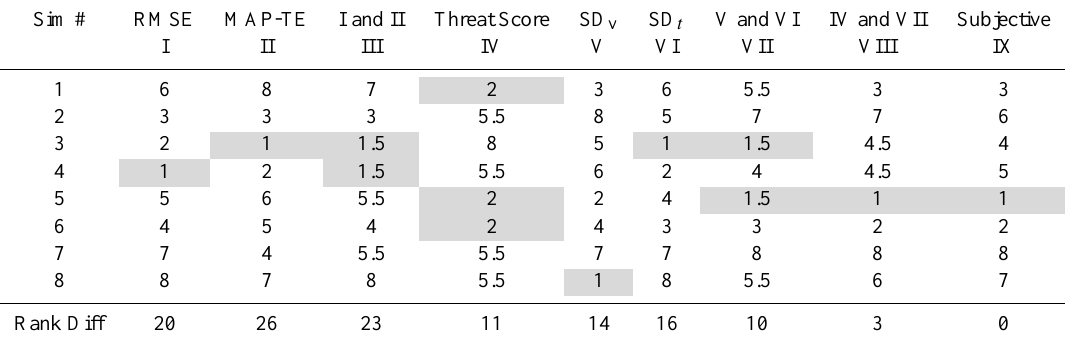
Table 3. Ranked metrics from Table 2 for 8 pairs of simulated and observed hydrographs as shown in Fig. 4. Ranks are determined separately for each column. Highest ranks are shaded grey. RMSE=Root Mean Square Error, MAPTE=Mean Absolute Peak Time Error, I and II=ranks of columns I and II added and ranked, SD v =Amplitude Error of Series Distance, SD t =Timing Error of Series Distance, V and VI=ranks of columns V and VI added and ranked, IV and VII=ranks of columns IV and VII added and ranked, Subjective=subjective classification by the authors, Rank Diff=Accumulated rank difference between subjective ranking (column IX) and the ranks in the respective